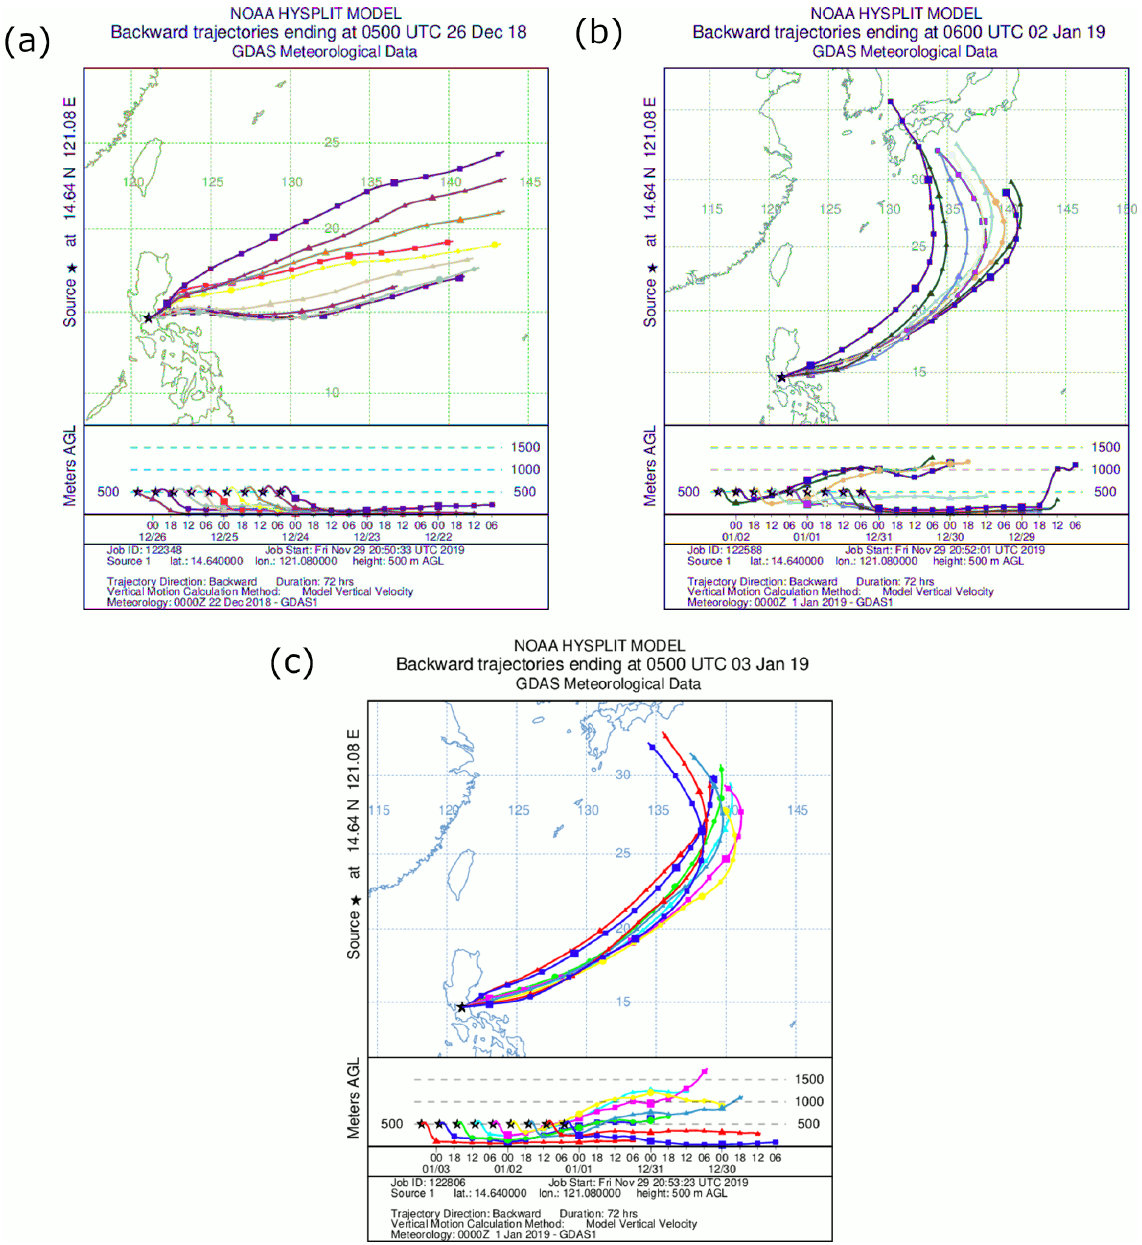
Figure 2. Three-day back trajectories with 6h resolution for the periods (a) before, (b) during, and (c) after the firework event, ending at the point of the Manila Observatory at